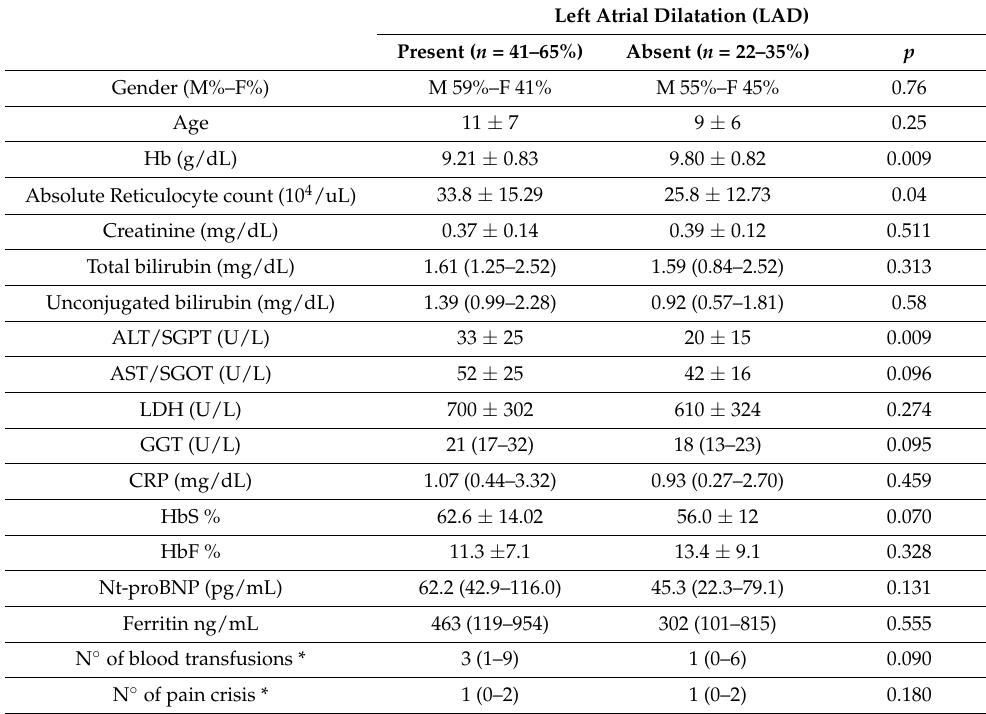
Table 3. Clinical and laboratory data of study groups based on the presence of LAD.